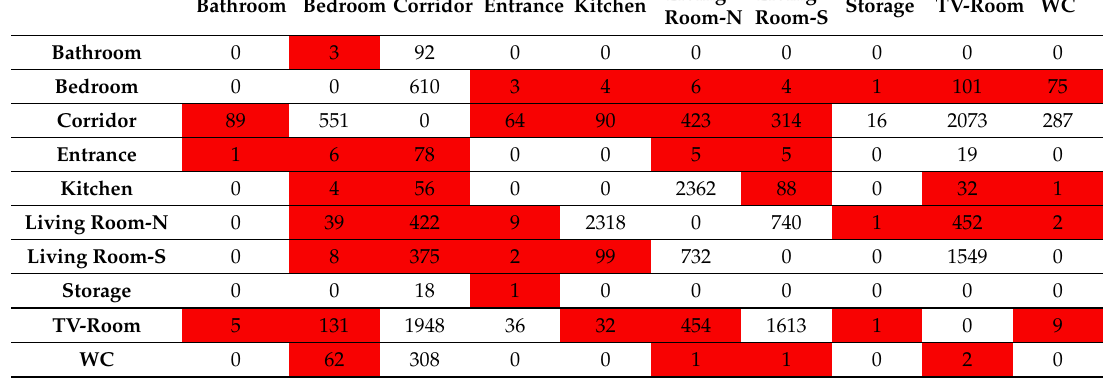
Table 1. Confusion matrix of transitions in deployment phase: Transitions between non-adjacent locations are filled in red as false